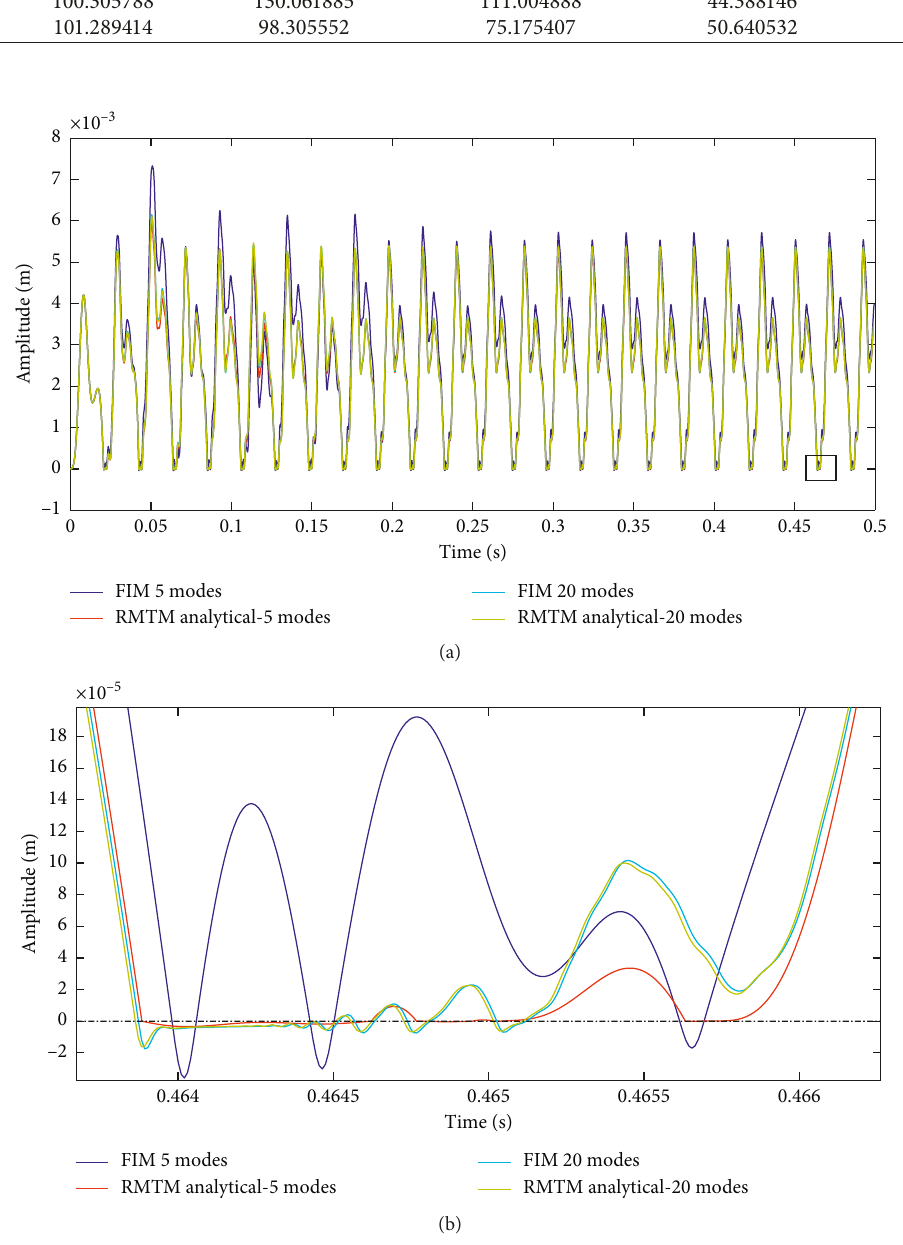
Figure 11: Effect of mode number and methods on sticking motion: ω � 95 Hz, damping ratio ξ � 0 . 02, and hard impact k ∗ � 13000 ( k � 1 × 10 7 N/m ) . (a) Time-history. (b) Contacting vibration, local amplification of the rectangle in (a).